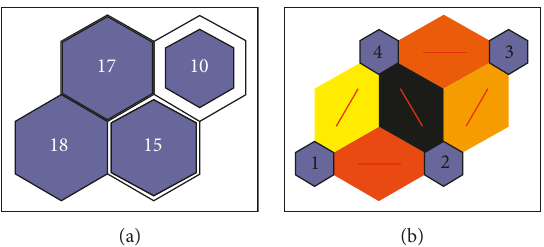
Figure 5: (a) Visualized clustering results and (b) weight distances between adjacent neurons of the identification model of water- adulterated salmon based on feature spectra and features of color